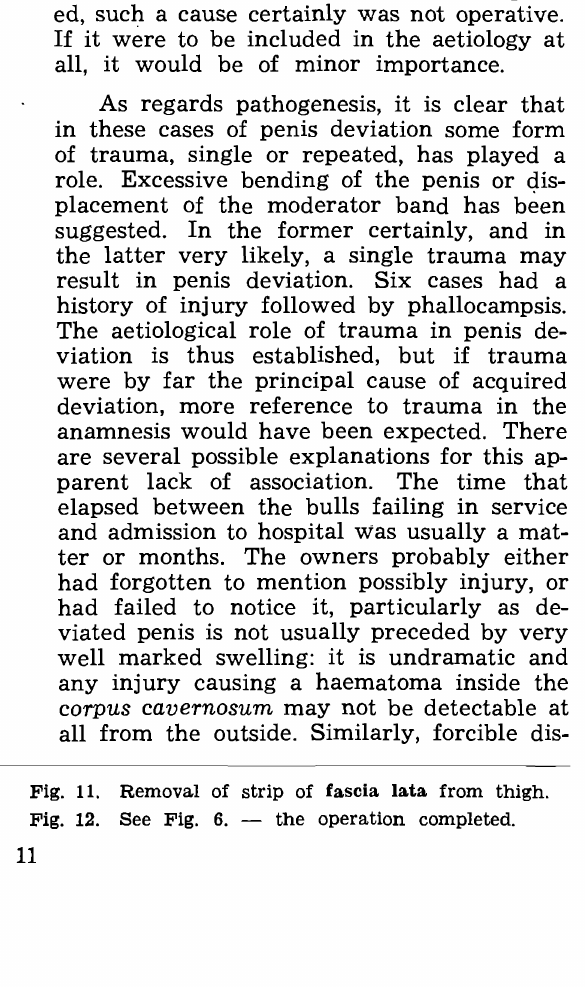
Fig. 11. Removal of strip of fascia lata from thigh. Fig. 12. See Fig. 6. - the operation